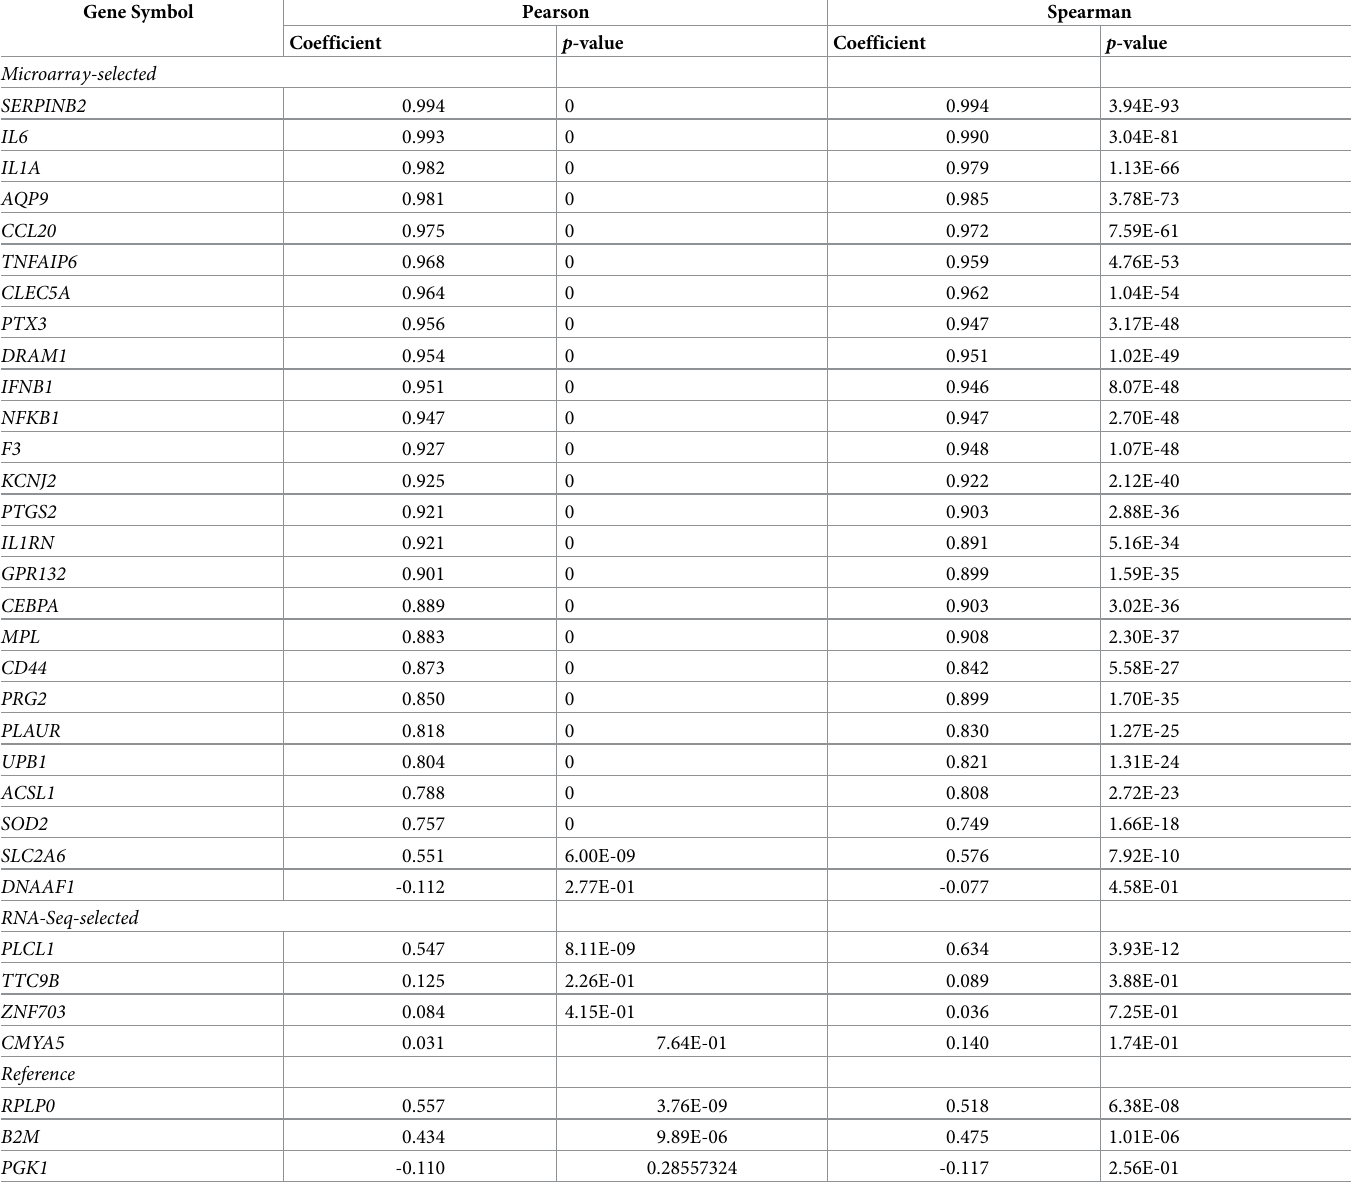
Table 2. Correlation of expression levels between microarray and nCounter in all 90